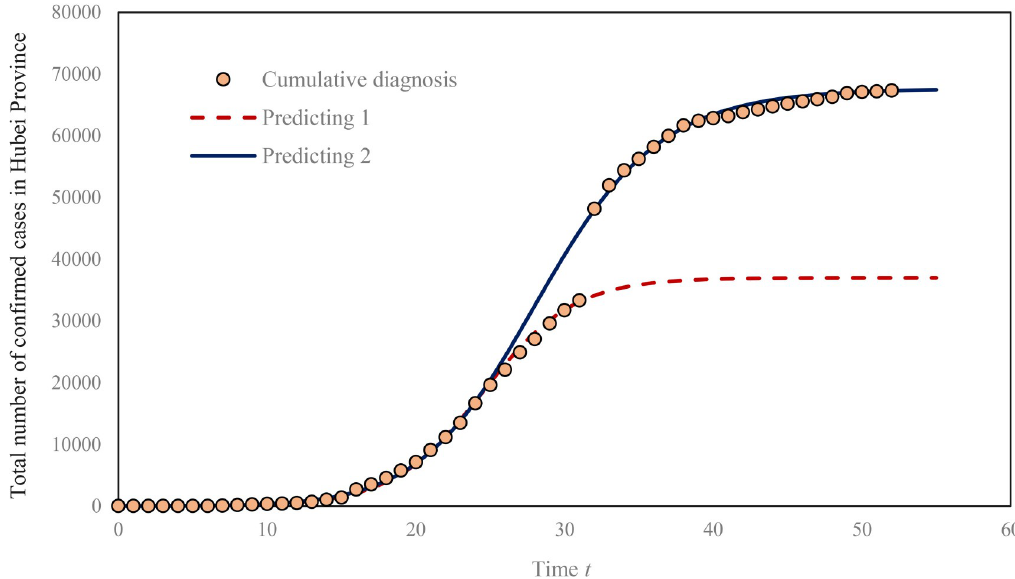
Fig 3. The sigmoid growth curve and the logistic process of total number of confirmed cases of COVID-19 in Hubei Province. Due to the adjustment of the diagnosis standard of COVID-19, the statistical caliber has varied several times. The most significant change took place on February 12, 2020. Statistically speaking, the growth rate of the total number of confirmed cases on February 12 is an abnormal value. From February 19 to 26, the statistical caliber seemed to be changeable again for the value is abnormal to some extent. Here are two trend lines based on two sets of data with different statistical calibers. The first logistic curve is more consistent with the growth rate, and the second fractional logistic curve can reflect the capacity of confirmed cases. The bifurcation point of these two curves is around February 4 and 5. The growth rate of COVID-19 reached its peak on these two days.